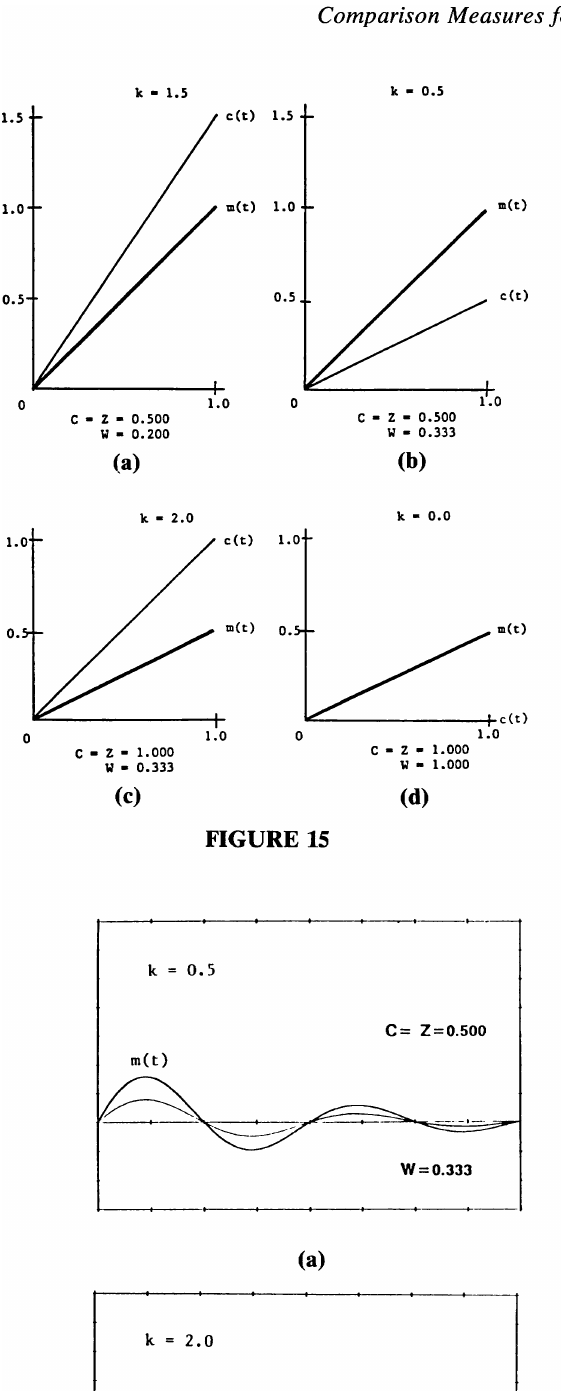
ture of eyeballing for exponentially decaying